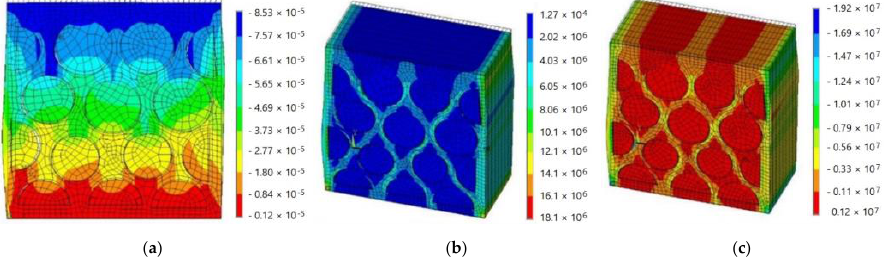
Figure 12. The behaviour of the cordwood specimen C-1, obtained by the FEM model: ( a ) displace- ments of cordwood specimen under the action of maximum compression force in the direction of